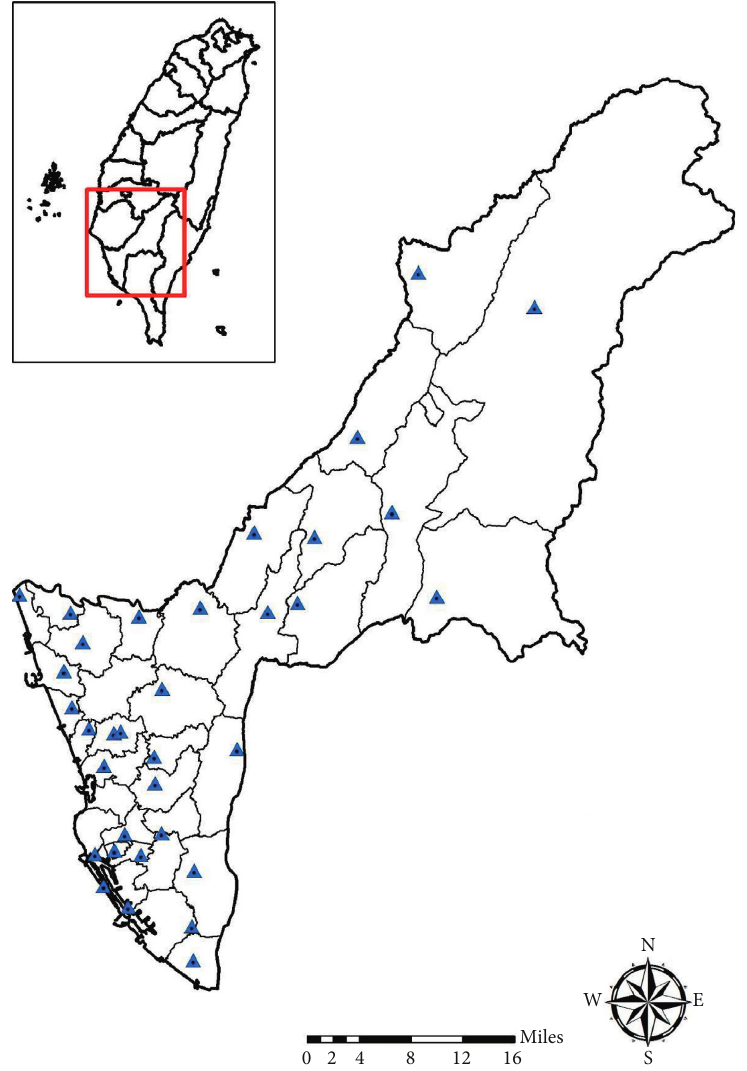
Figure 1: Map of Kaohsiung City, Taiwan (22 o 38 ′ N , 120 o 16 ′ E ). The city is divided into 38 districts. The locations of automatic observation stations and weather stations of the Kaohsiung City are shown ( ▲